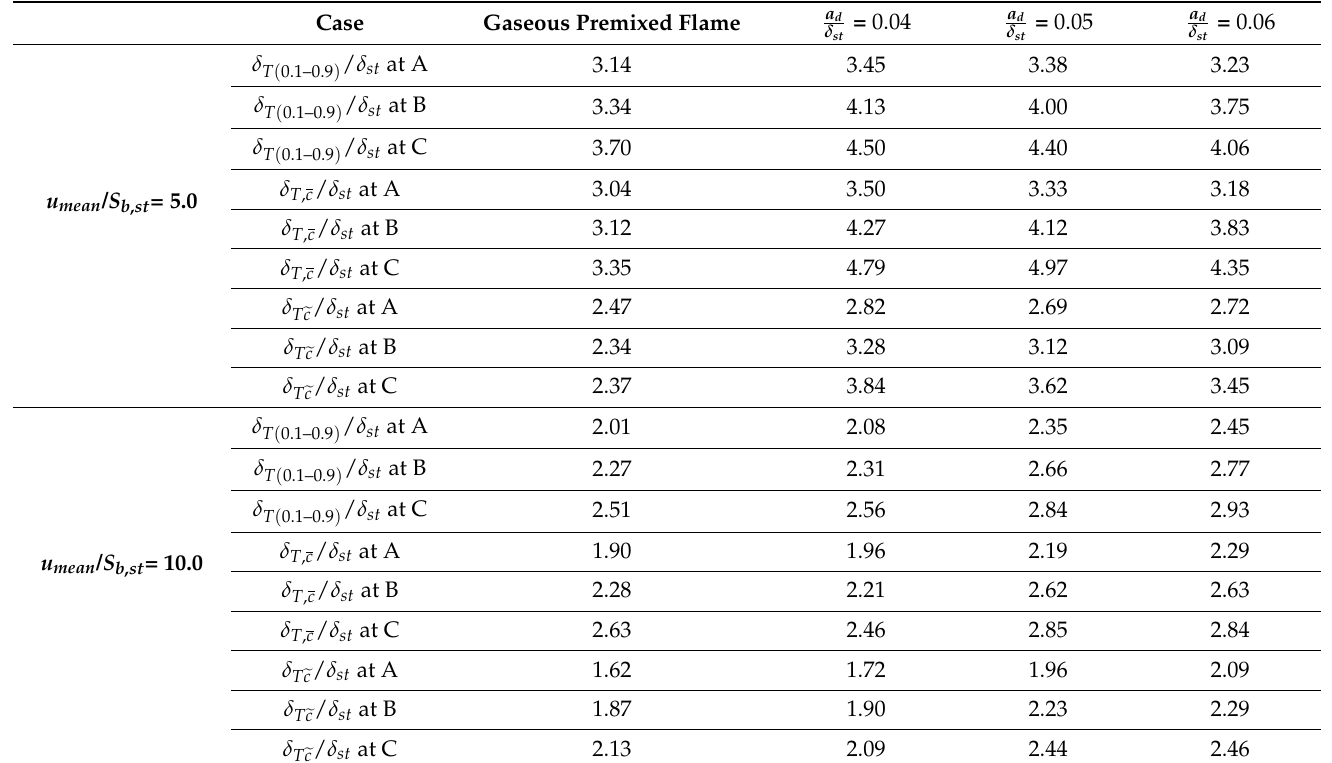
Table 1. Flame brush thickness at locations A, B and